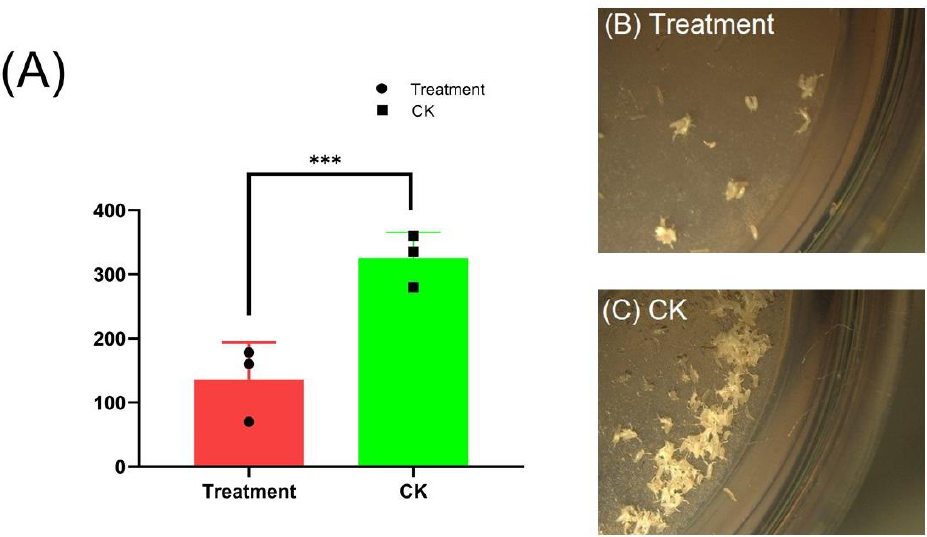
Figure 7. Effect of cyromazine on fecundity of Drosophila melanogaster . ( A ) Twenty mated female flies were used for each replication (N = 60). The number of laid eggs decreased from 325 ± 40.9 (CK) to 136 ± 57.8 (Treatment). ( B , C ) Significant decrease in the fecundity of the 3-day-old female adult was observed, as compared to the control group. The p -value of Student’s t -test is: *** p < 0.001.